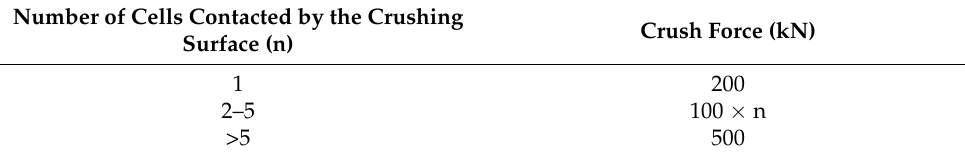
Table 3. Crush force as per GB/T 31485-2015:2015 [90]. Number of Cells Contacted by the Crushing Crush Force (kN) Surface (n) 1 200 2–5 100 × n >5